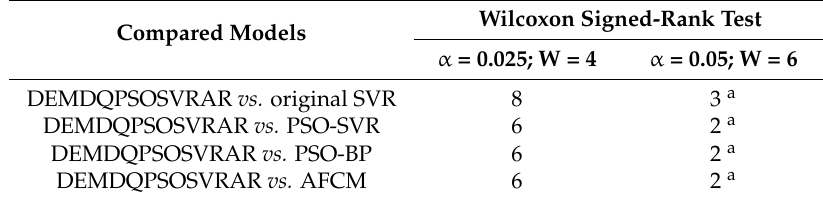
Table 9. Wilcoxon signed-rank test in Case 1.